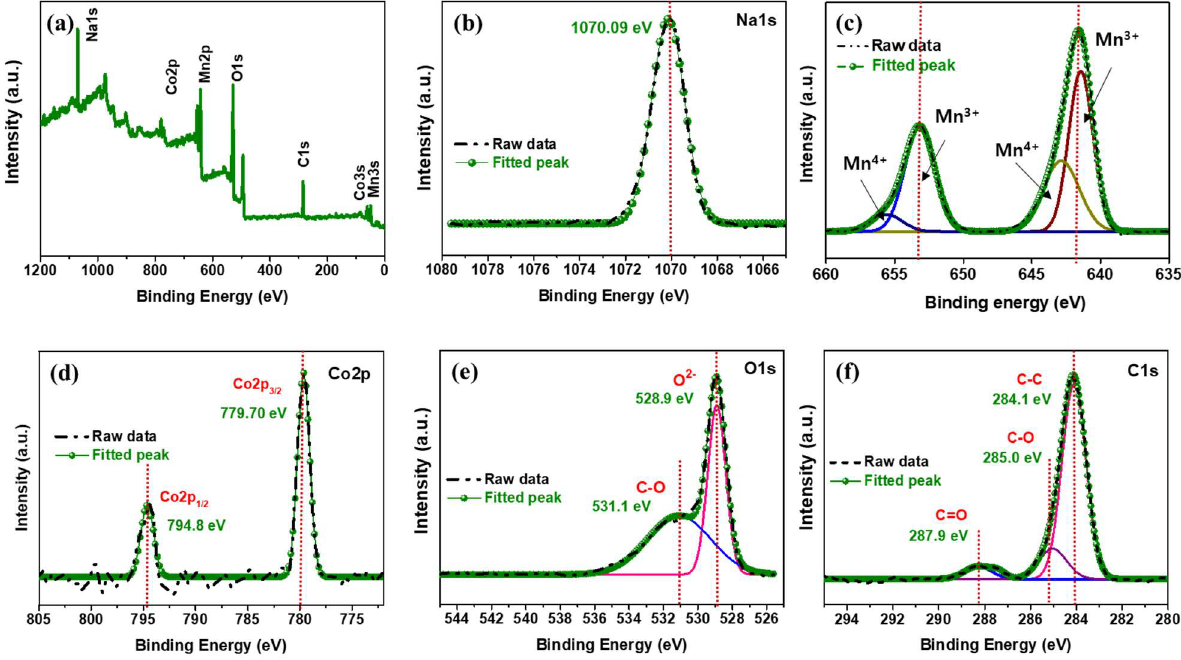
Figure 5. XPS spectra of the NaCM- iB cathode material: ( a ) survey spectrum and high-resolution ( b ) Na1s, ( c ) Mn2p, ( d ) Co2p, ( e ) O1s, and ( f ) C1s spectra.